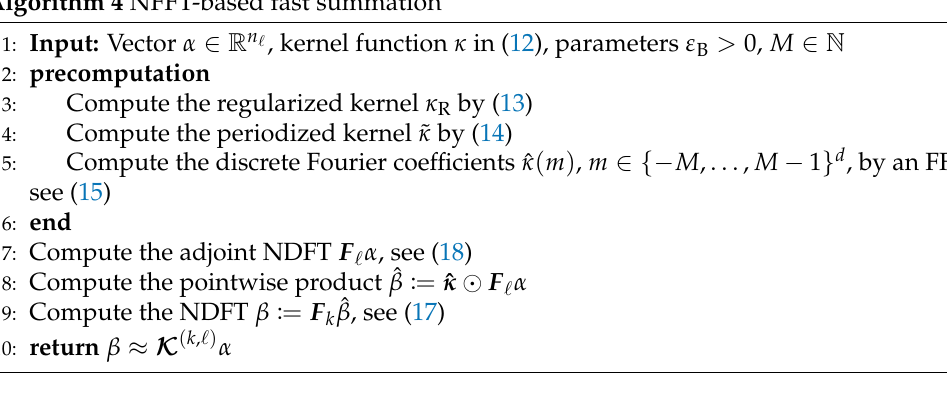
Algorithm 4 NFFT-based fast